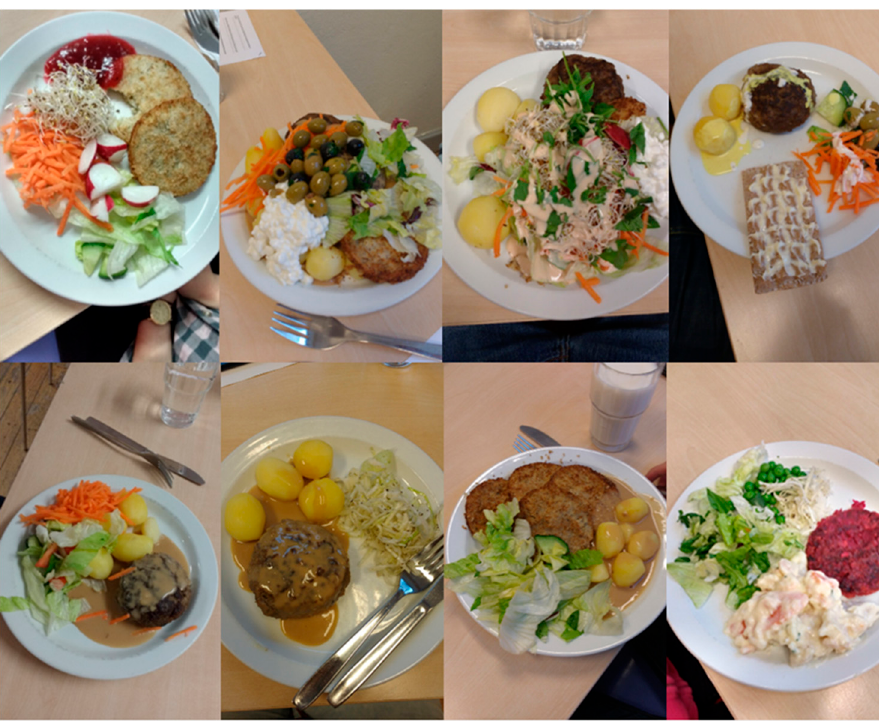
Figure 4. Food choices among a sample of the included